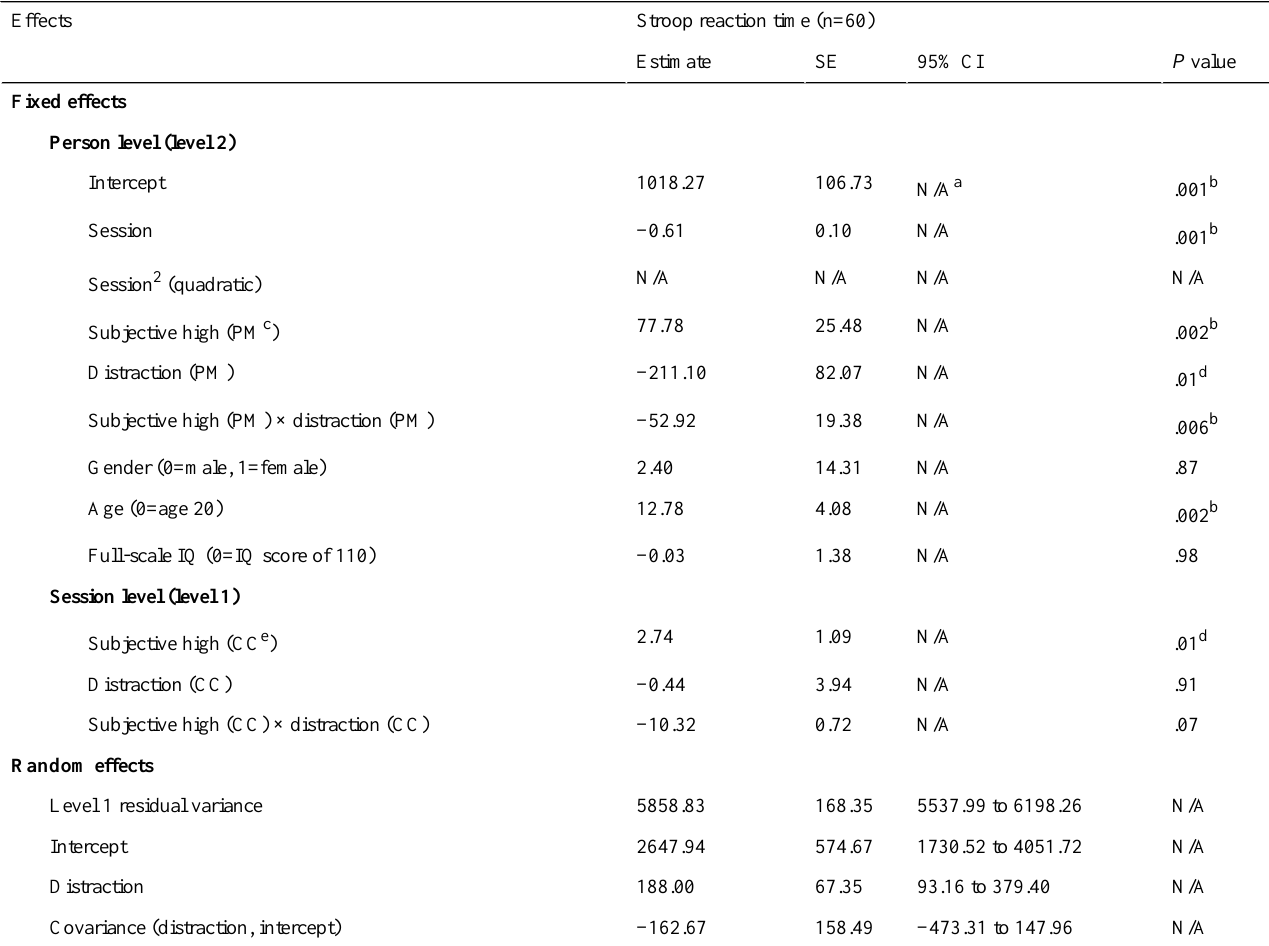
Table 4. Marijuana Stroop: multilevel model of marijuana high in relation to reaction